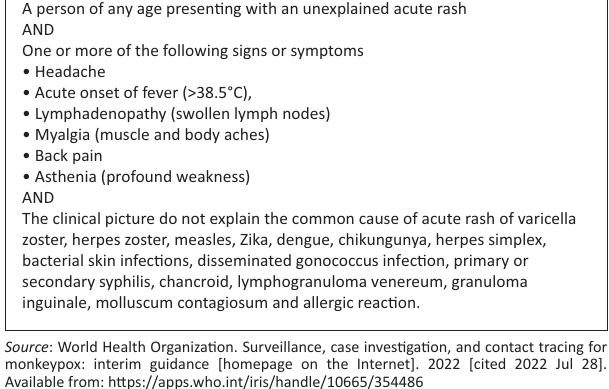
FIGURE 1: Suspected case definition of monkeypox.